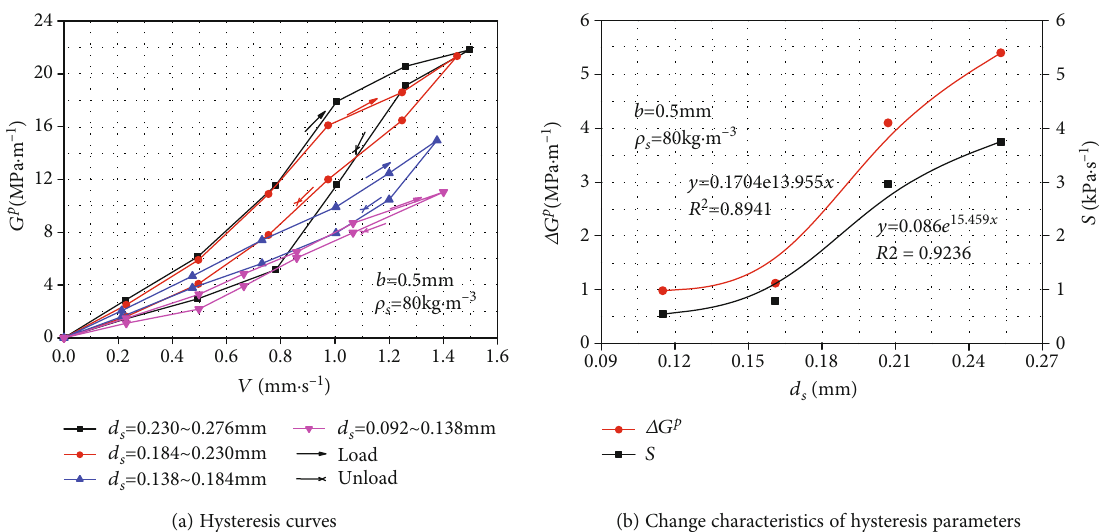
Figure 11: Hysteresis characteristics of water-sediment mixture seepage in fractures under the e ff ects of sand particle size.